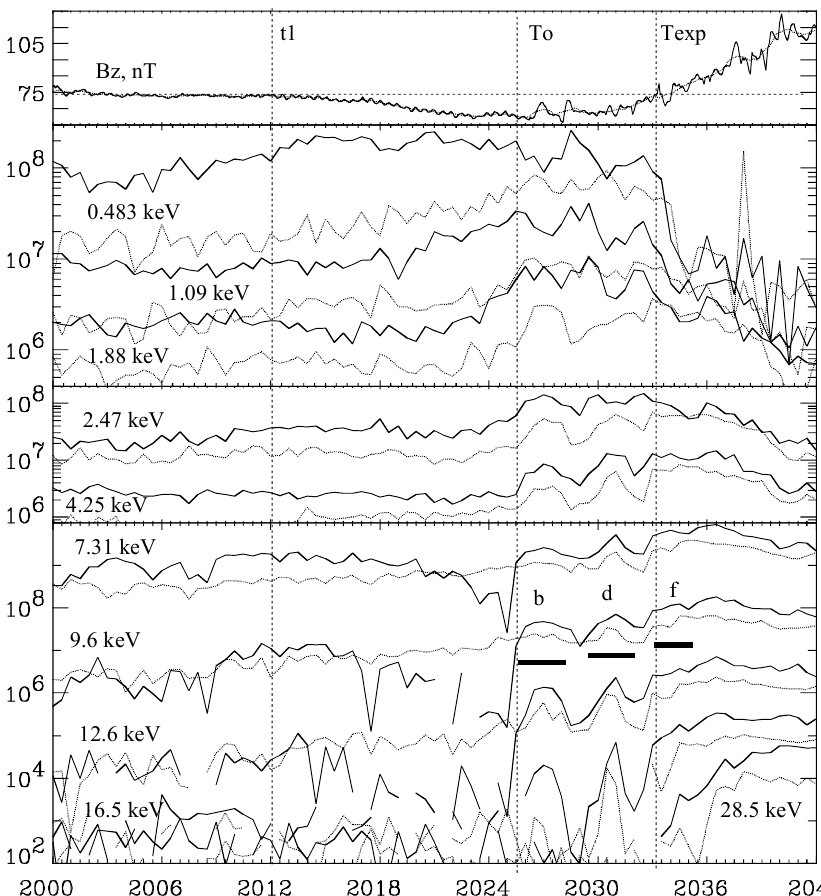
Fig. 5. Substorm on 12 March 1991. Data from the CRRES satellite. From top to bottom: Z-component of the magnetic field; the “A” and “B” populations of LEPA electrons are shown in the panels (2–3) and (4), respectively. Electron flux in cm − 2 s − 1 sr − 1 keV − 1 . Solid lines are the flux of particles with pitch-angles ∼ 90 ◦ ; dashes lines are the flux of particles with pitch-angles near the field-aligned